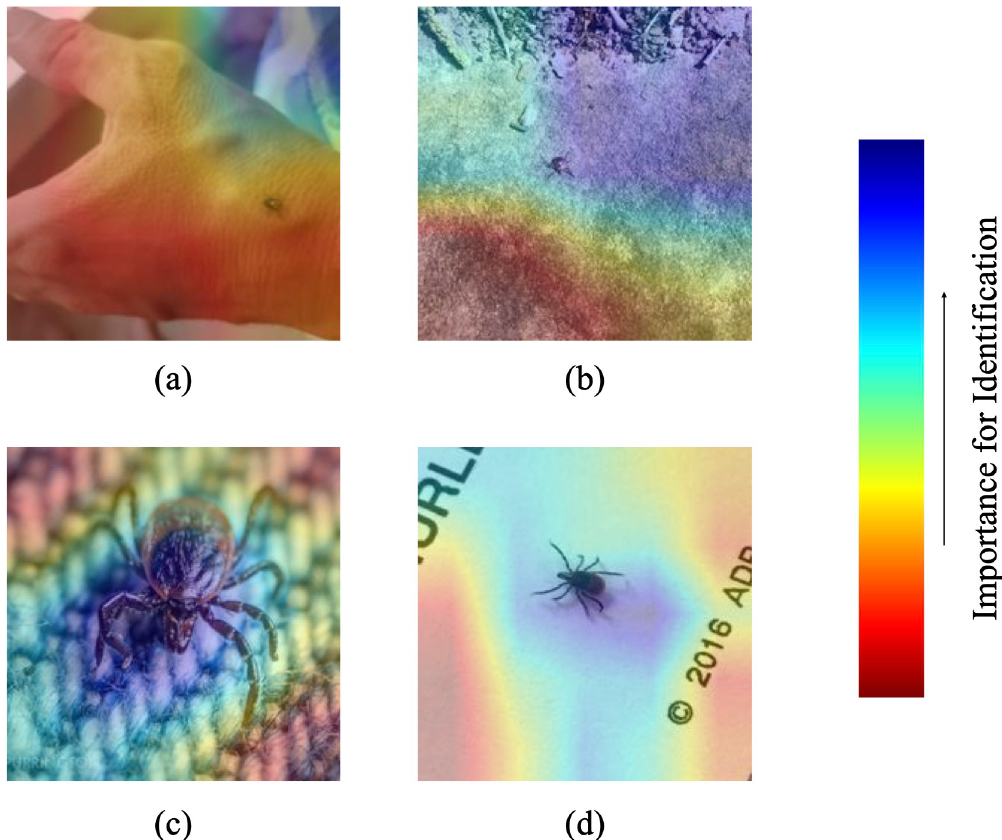
Fig 10. Grad-CAM heatmap visualizations of TickIDNet predicted images show the model failing to assign importance to the relevant parts of the images when RTS is small. The importance of shapes or regions in the image is ranked on a red- blue heatmap described by the scale on the right. (a) Dermacentor variabilis incorrectly identified as Amblyomma americanum with RTS = 15, (b) A . americanum incorrectly identified as Ixodes scapularis with RTS = 17, (c) I . scapularis correctly identified with RTS = 145, (d) I . scapularis correctly identified with RTS = 48.